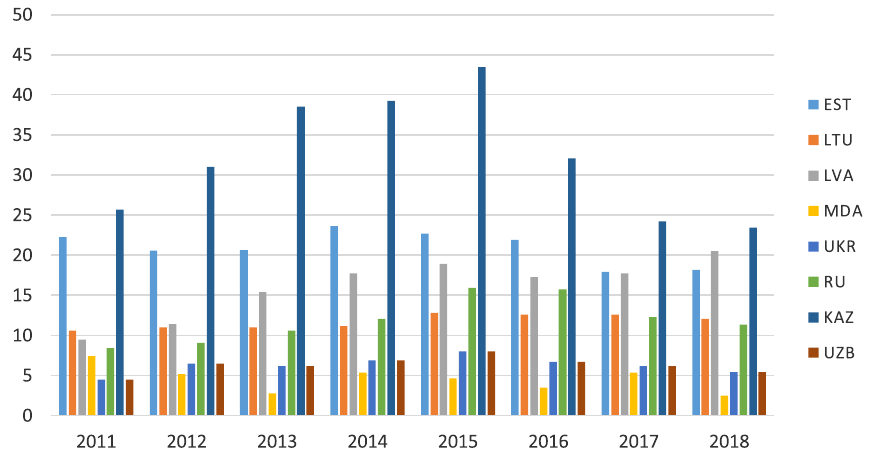
Figure 7. High-technology exports (% of manufactured exports) in post-Soviet countries.